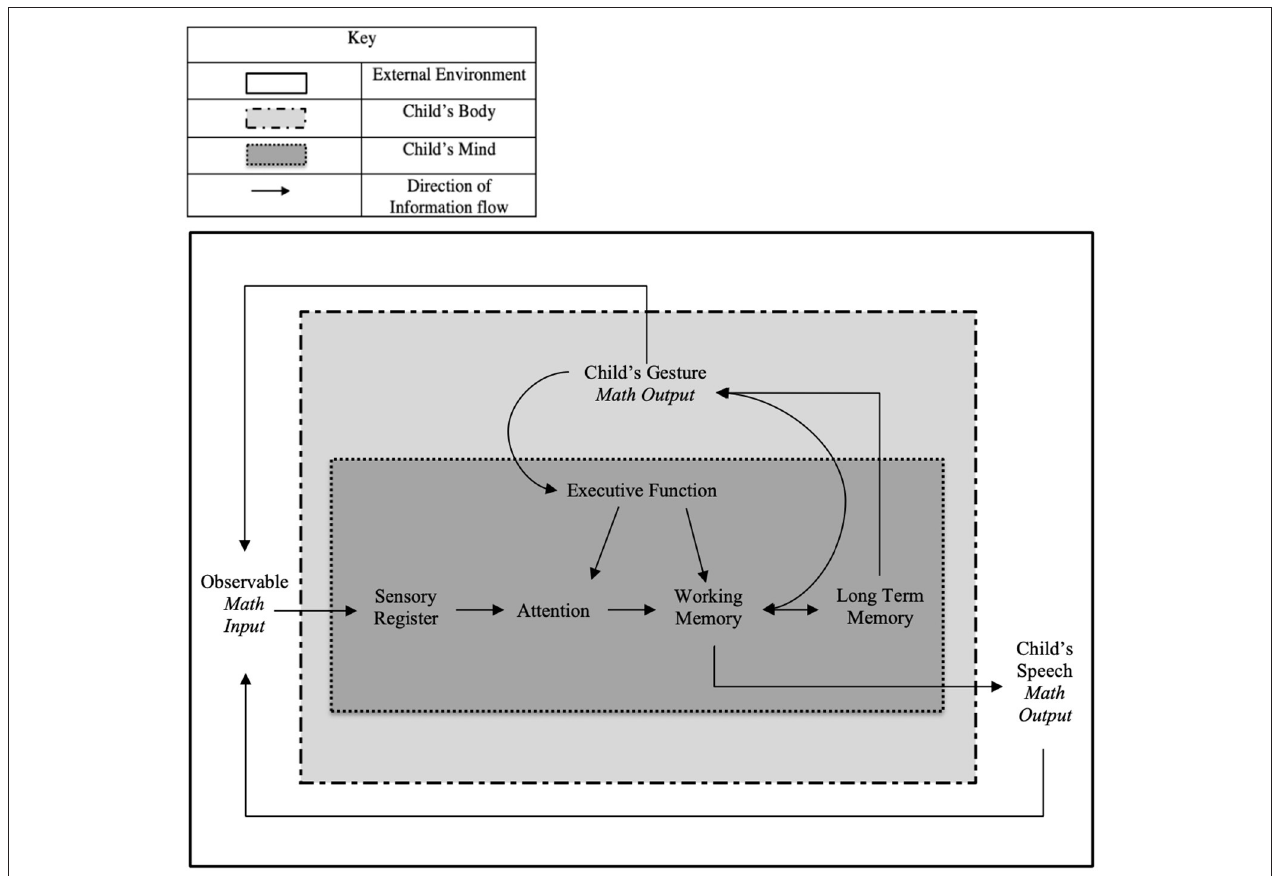
FIGURE 1 | Combined model of information processing and embodied